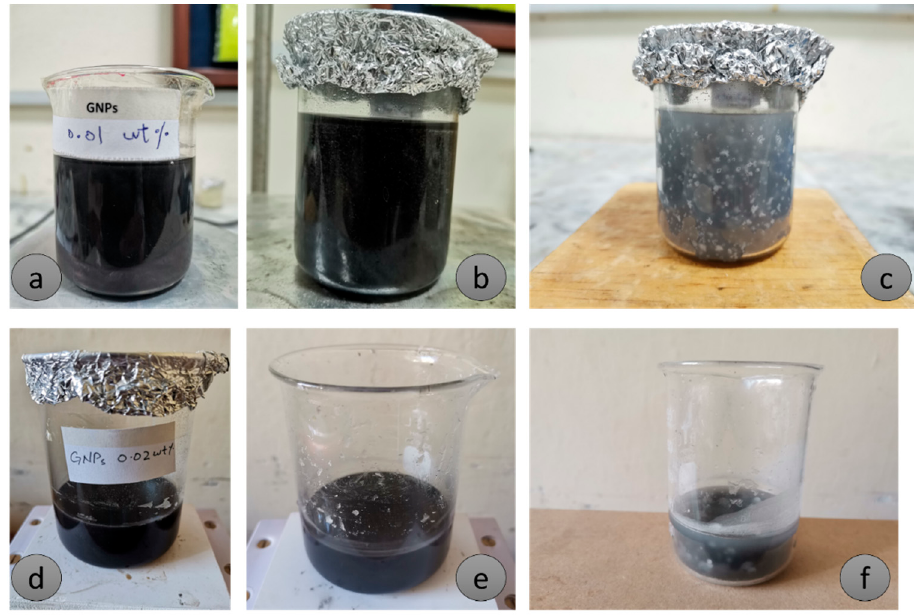
Figure 7. Schematic illustration of NEPCMs preparation.